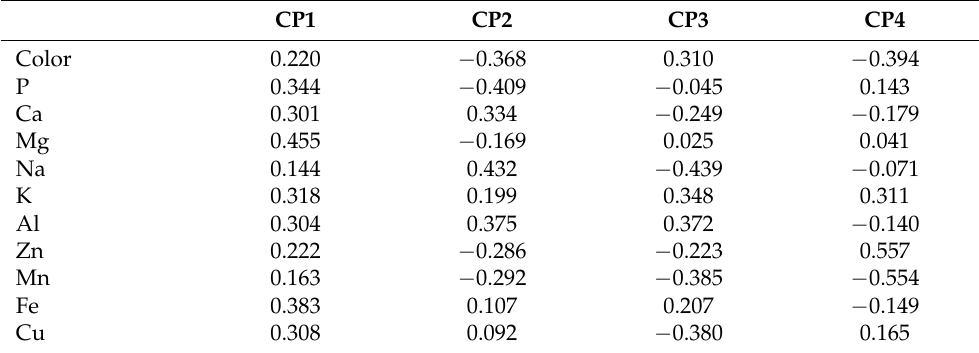
Table 8. Correlation matrix of principal component analysis for the variables color and mineral composition of honeys produced in Chile’s central-southern region.